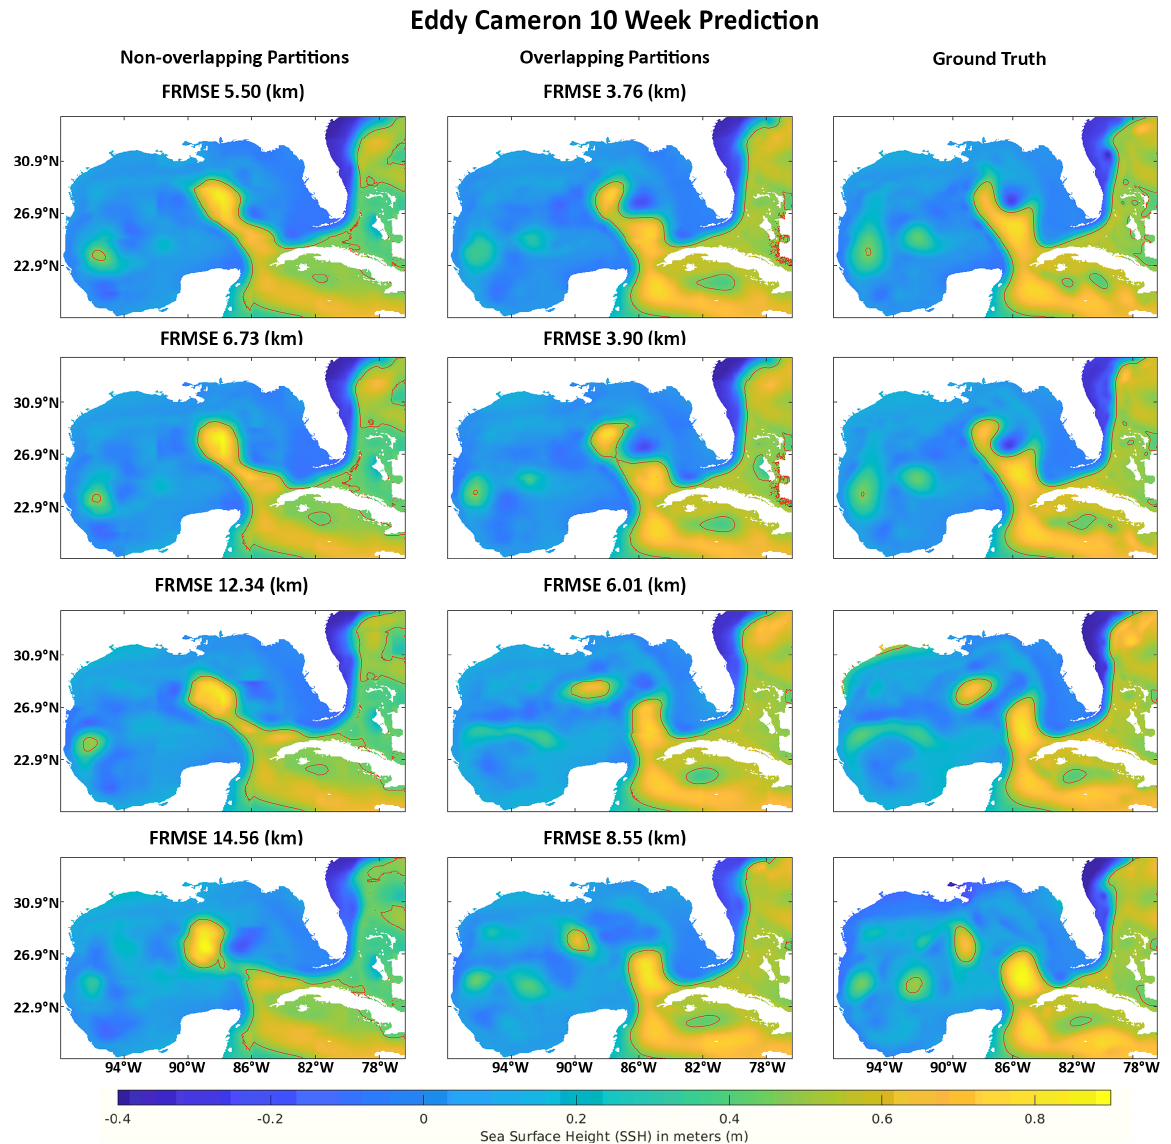
Figure 7. Presents the 10 week prediction of eddy Cameron with the non-overlapping DAC algorithm ( left ), overlapping DAC algorithm ( middle ), and ground truth ( right ). These results show that the original DAC algorithm, in a 10-week- ahead prediction does not capture the proper timing of the eddy shedding event of eddy Cameron. Notice the significant discontinuities that arise on the field as well, showing that perhaps errors in the pinched area may be responsible for misinforming the timing of the shedding. We also provide a 0.45m contour to better show the location of the eddy